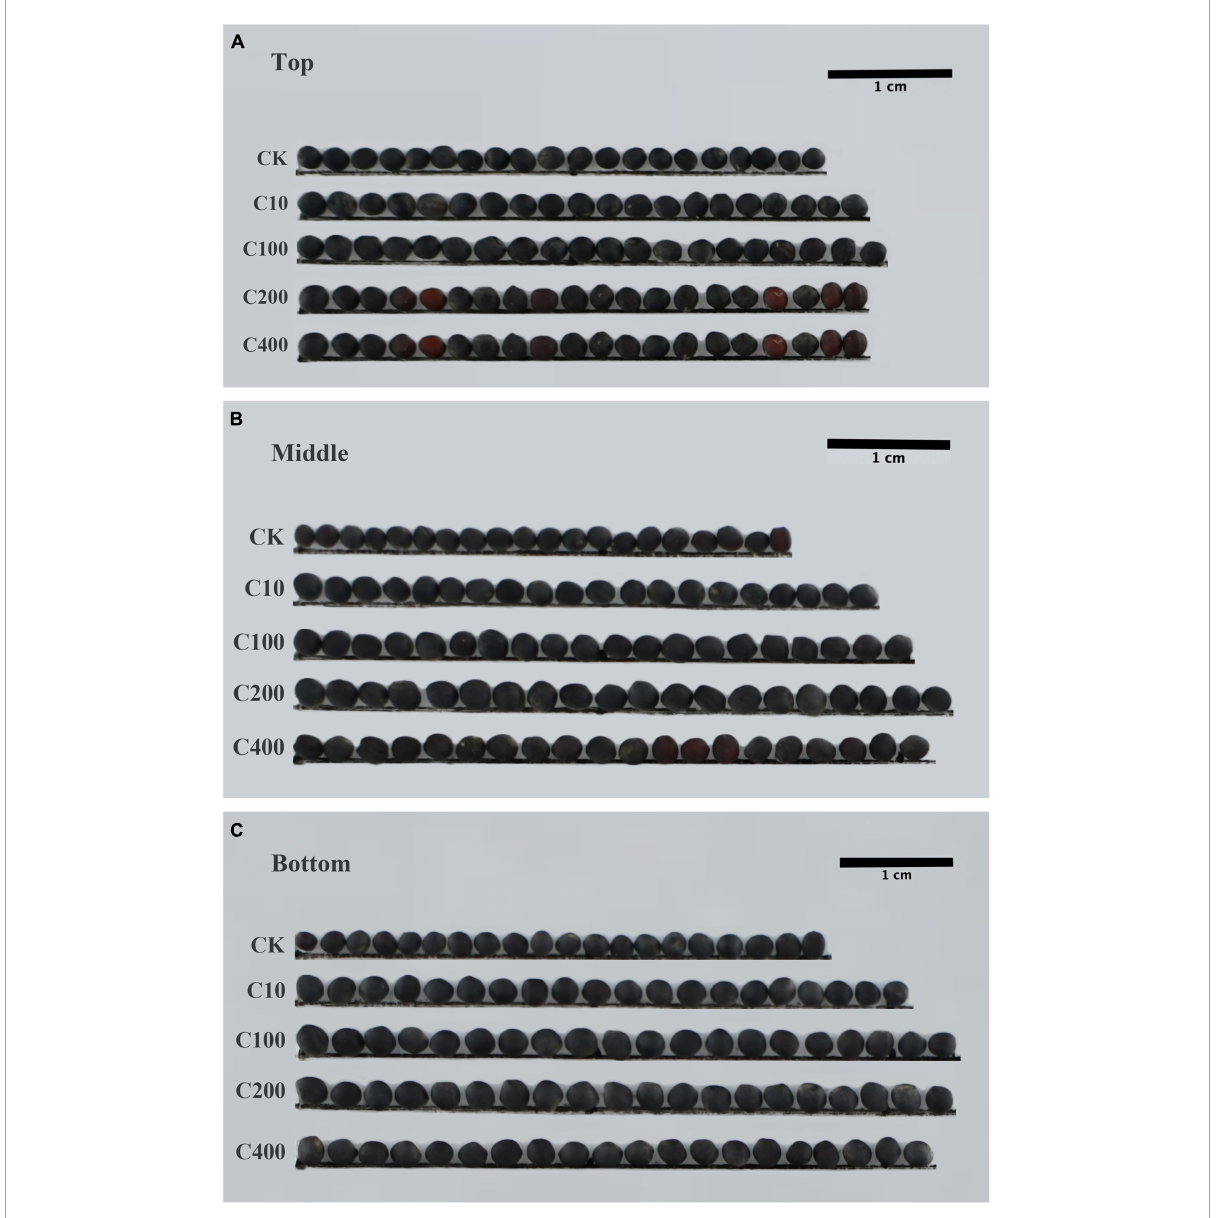
FIGURE2 Effect of TDZ treatment on seed size of B. napus . (A) Siliques in the top; (B) siliques in the middle; (C) siliques in bottom; CK: control; C10: 10 µ mol/L TDZ; C100: 100 µ mol/L TDZ; C200: 200 µ mol/L TDZ; C400: 400 µ mol/L TDZ; Scale bars: 1 cm.